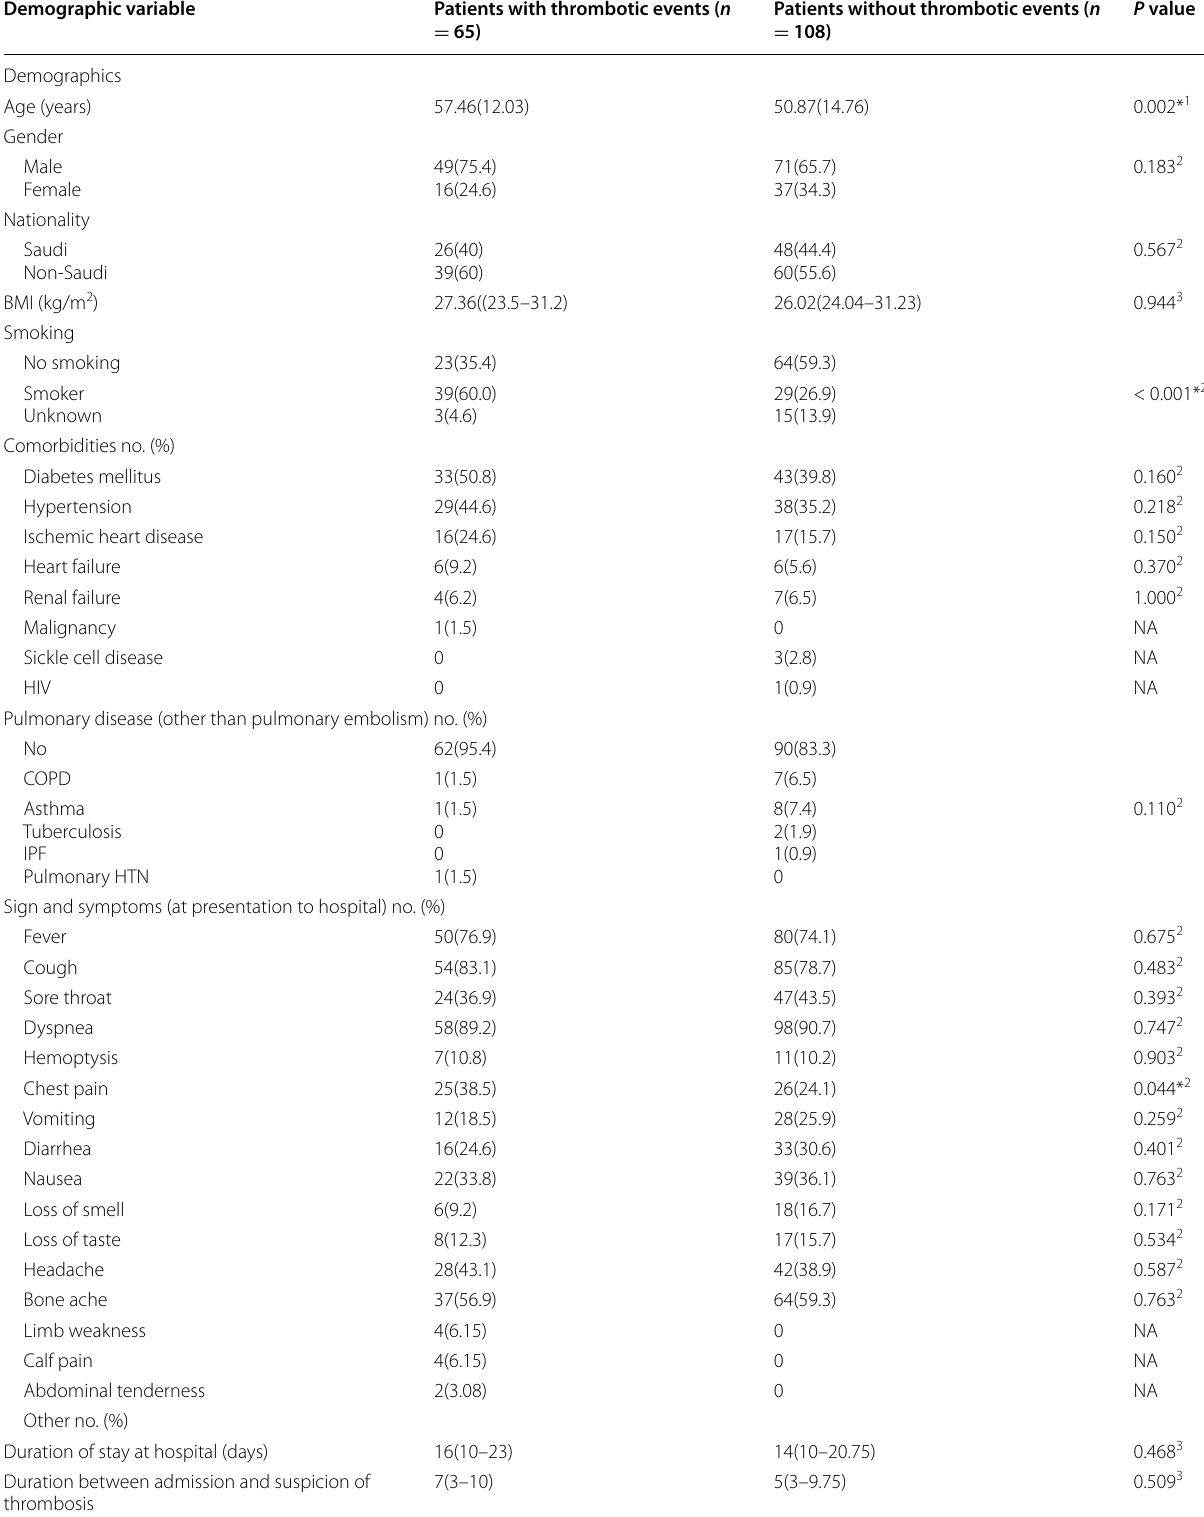
Table 2 Baseline demographic, comorbidities, and associated diseases in two groups of COVID patients Demographic